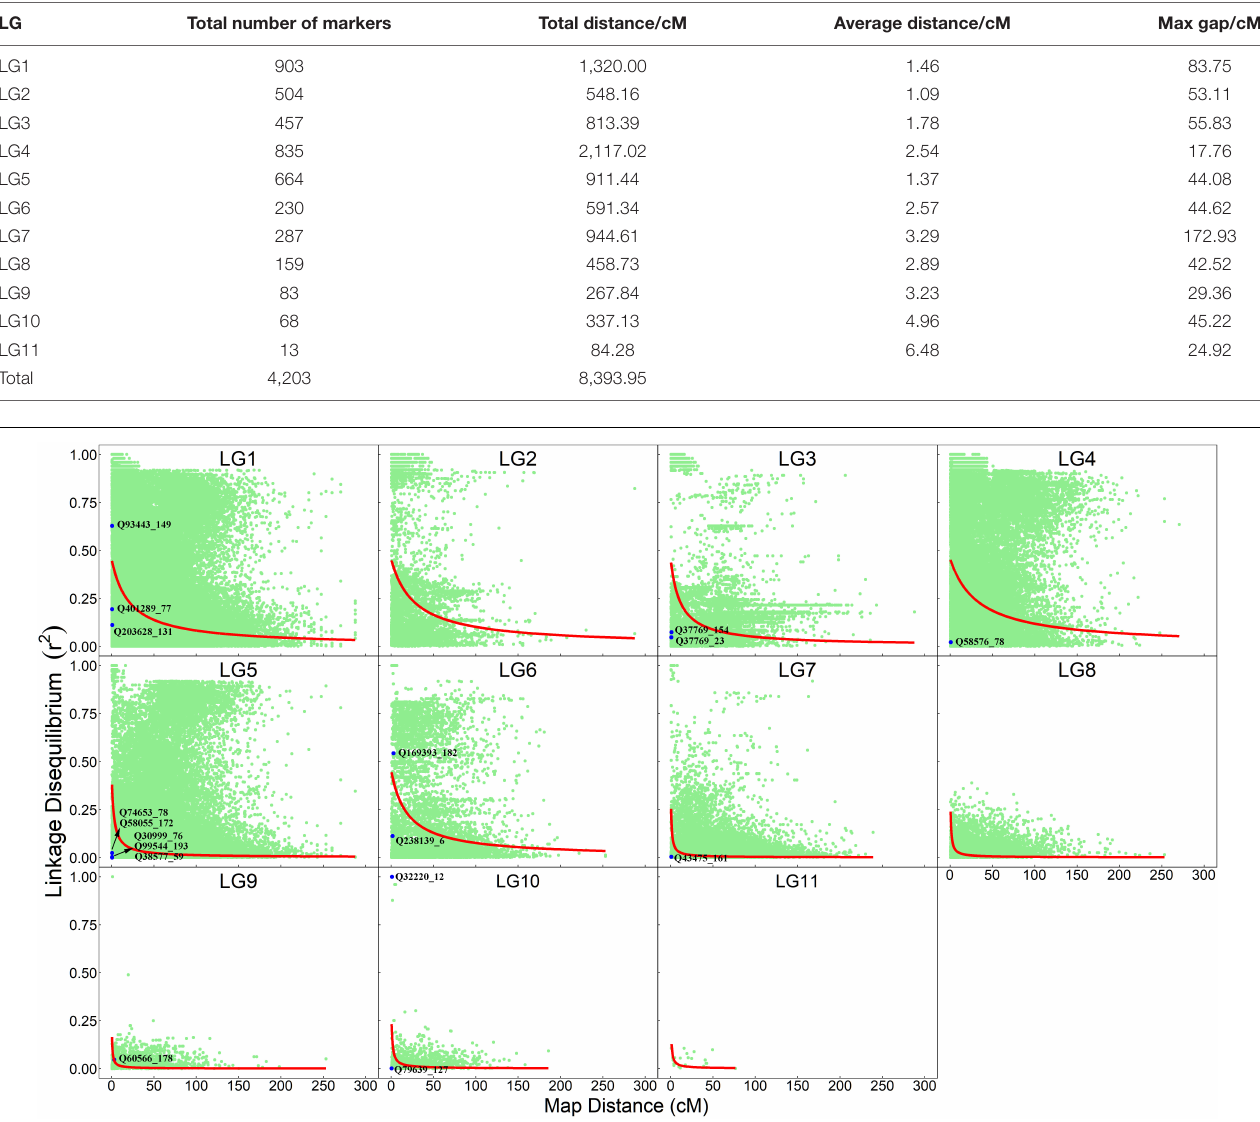
TABLE 1 | Statistical information of genetic linkage groups in T. grandis .